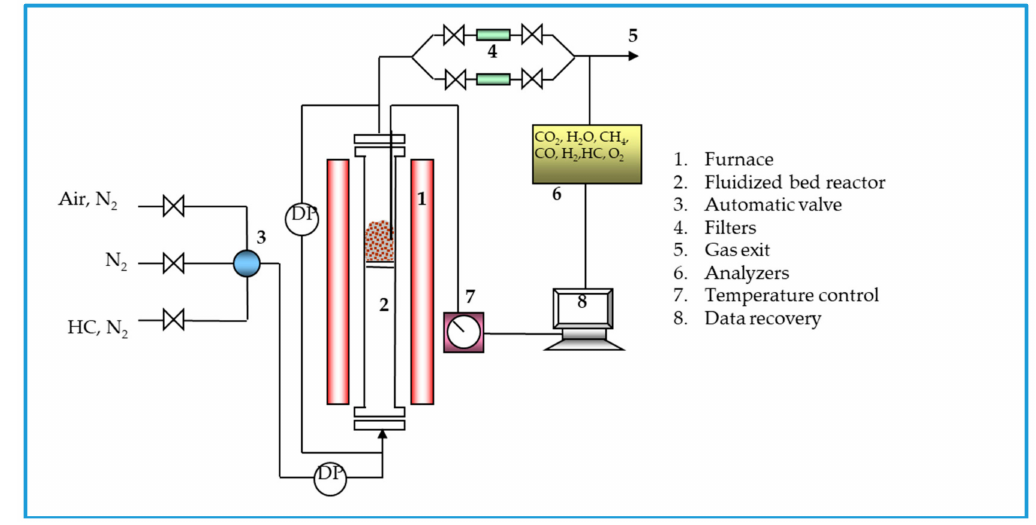
Figure 1. Diagram of the discontinuous chemical looping combustion (CLC)